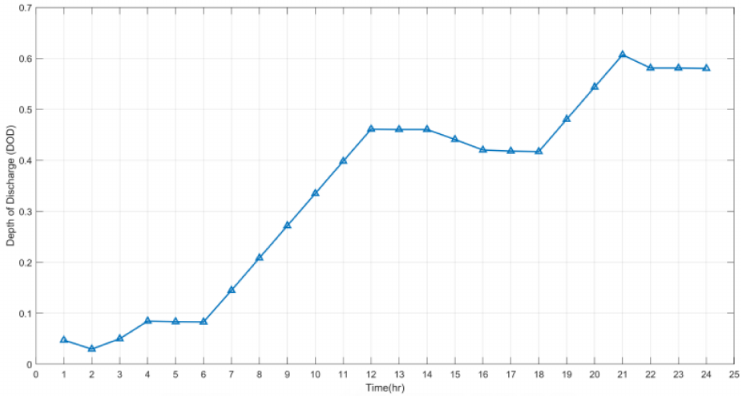
Figure 11. The depth of discharge of BESS in Scenario